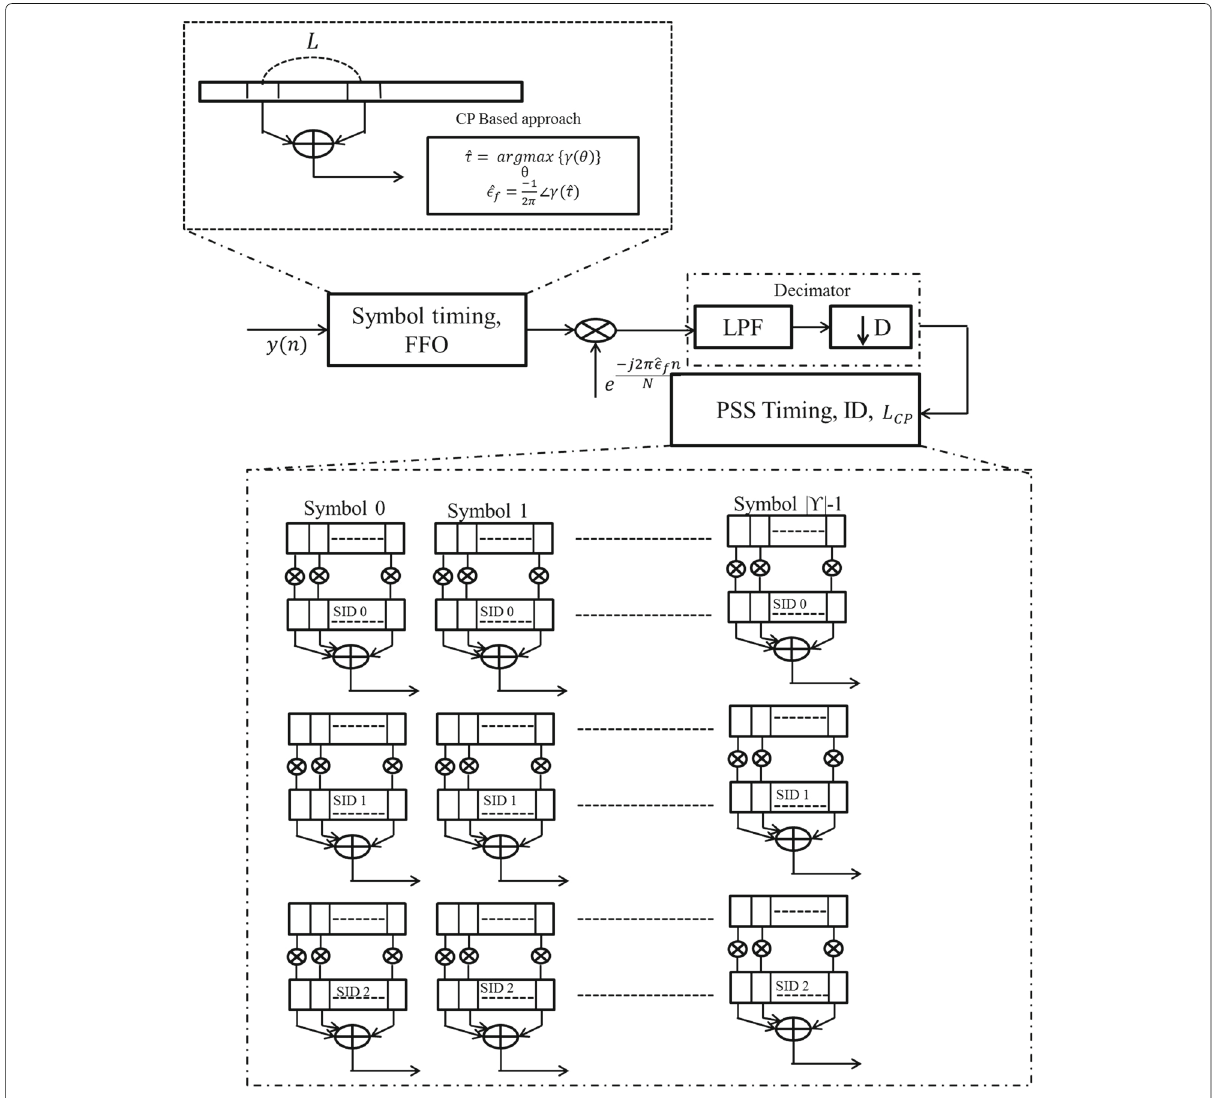
Fig. 2 Complete procedure of module I explained